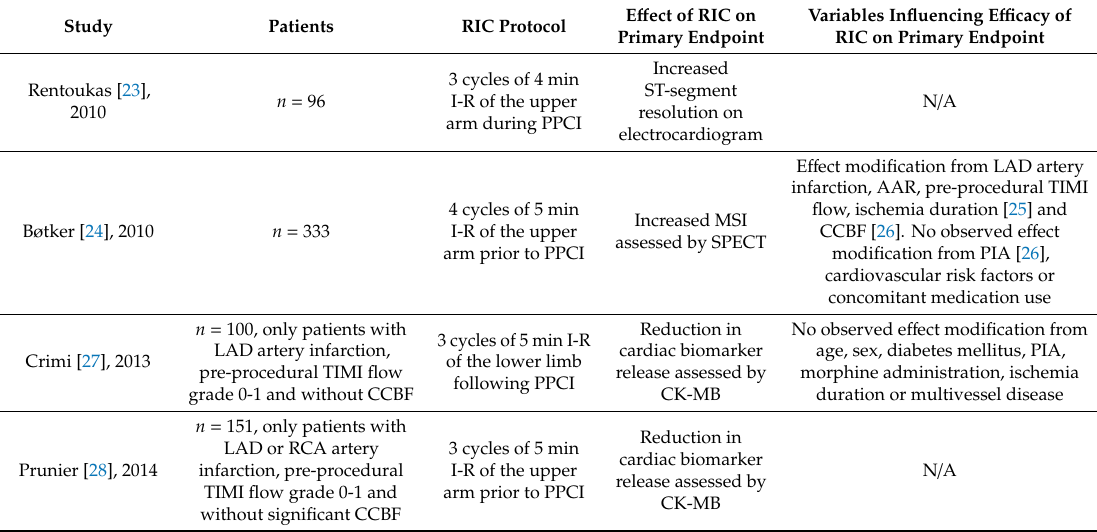
Table 1. Overview of Clinical Studies on the E ff ect of remote ischemic conditioning (RIC) and Influencing Factors on Primary Cardiovascular Endpoints in Patients with ST elevation myocardial infarction